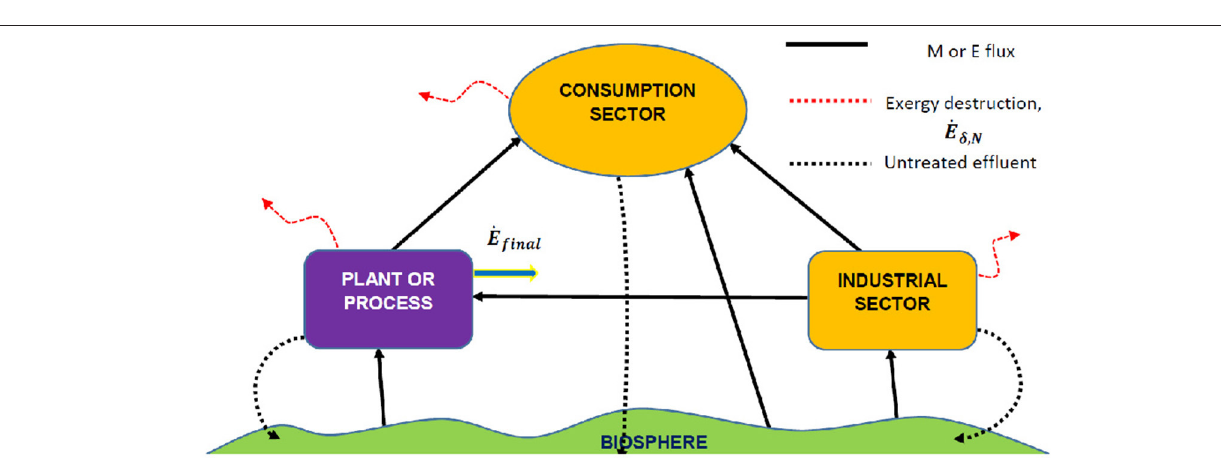
production of a material good from raw materials to the final product: the corresponding control volume is shown in Figure 7 . The rationale of CExC is that the